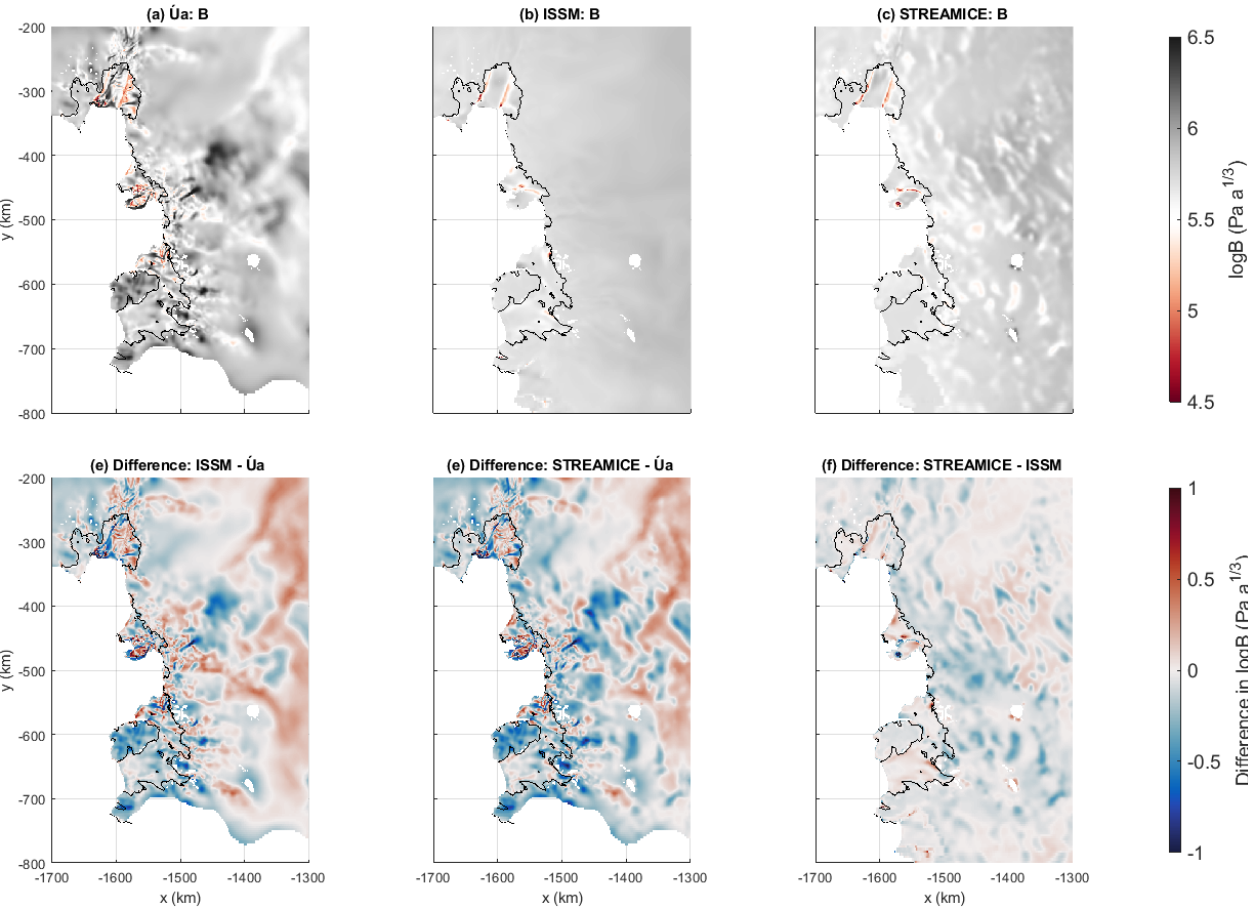
Figure 4. The B fields calculated by inversion and differences between them, displayed on a logarithmic colour scale in units of Paa 1 / 3 . The grounding line is indicated in